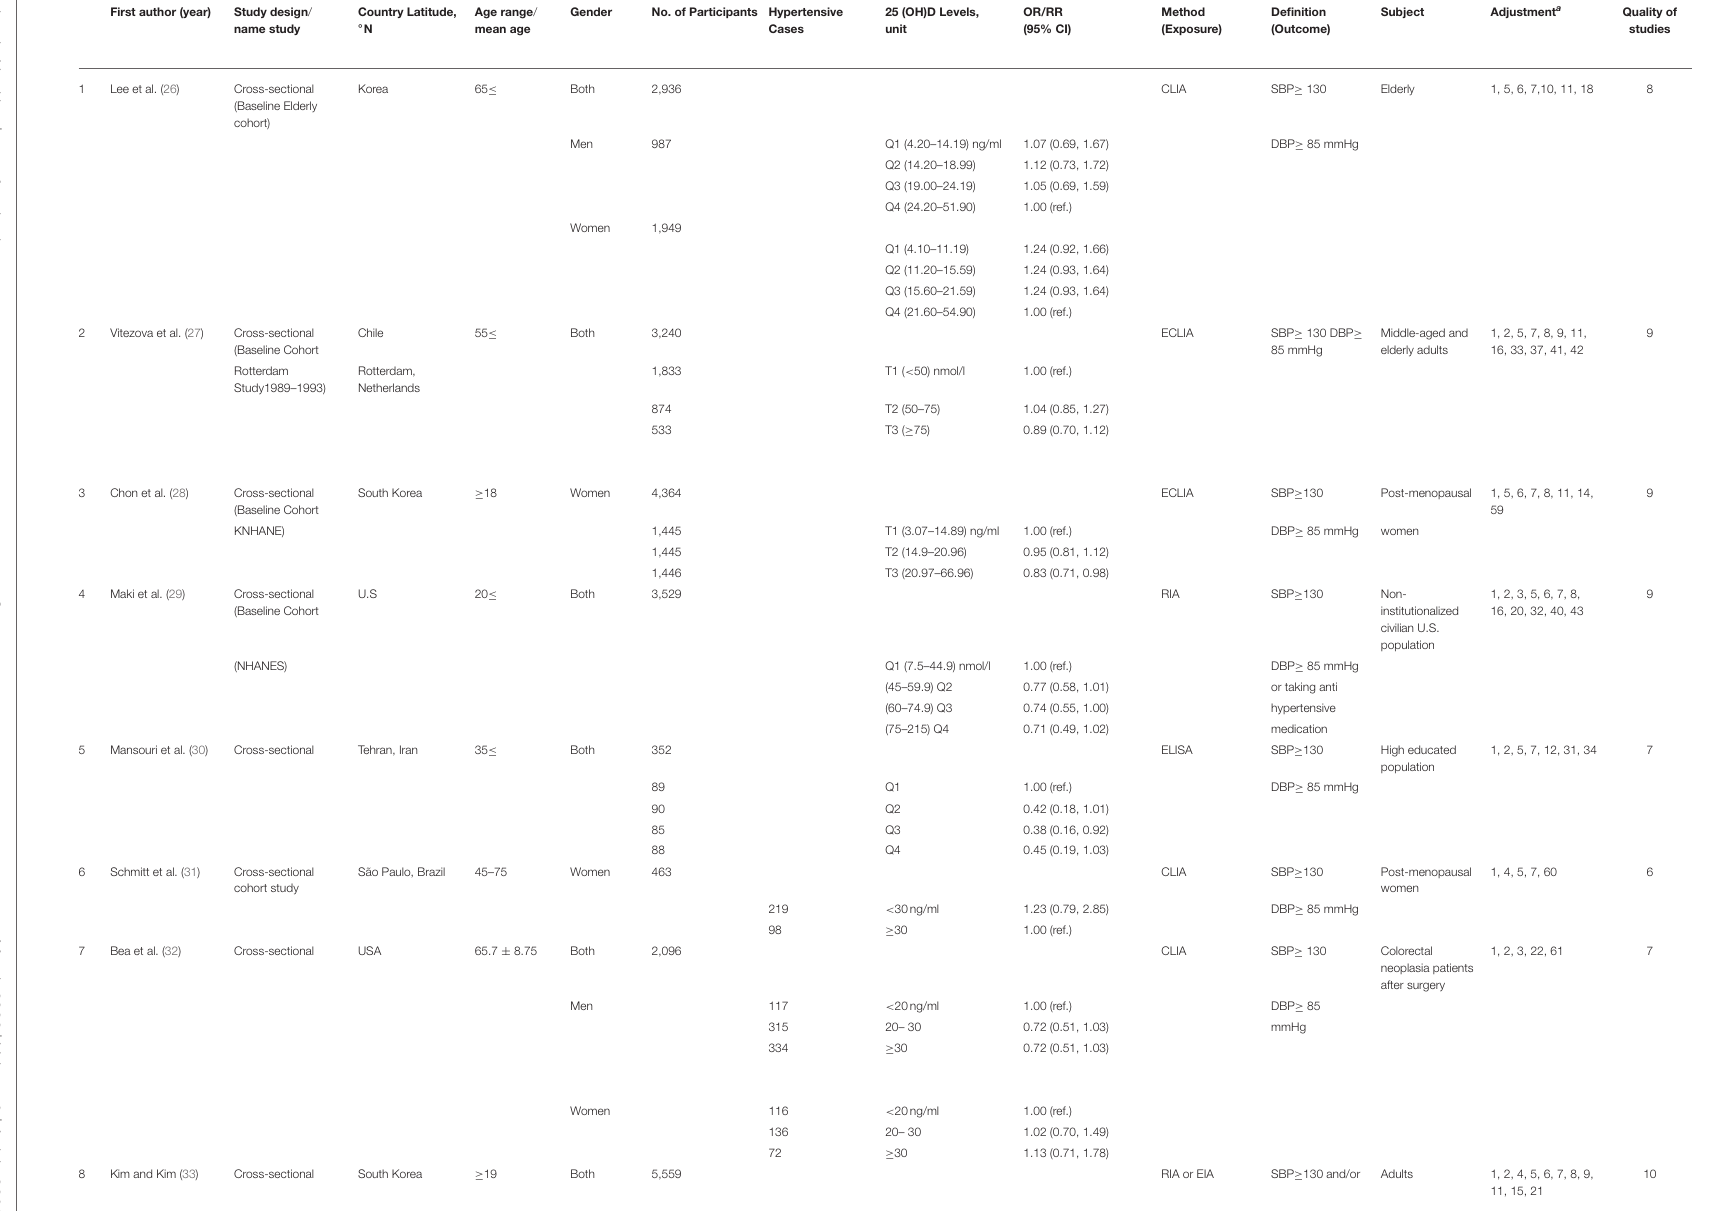
TABLE 1 | Main characteristics of included cohort and cross-sectional studies examined the association between serum vitamin D levels and high blood pressure in